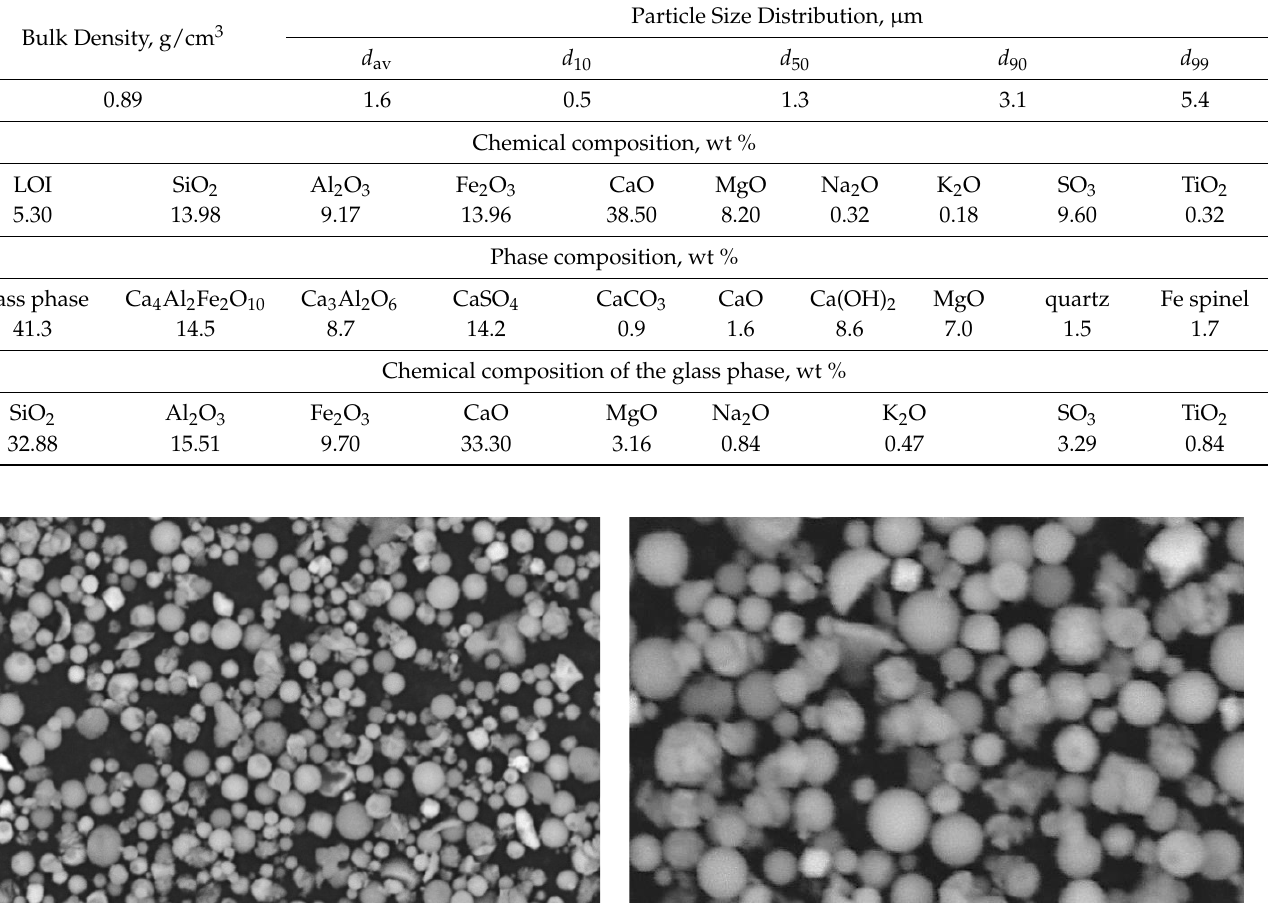
Table 1. Bulk density, particle size distribution parameters, and chemical and phase compositions of the fine narrow fraction.